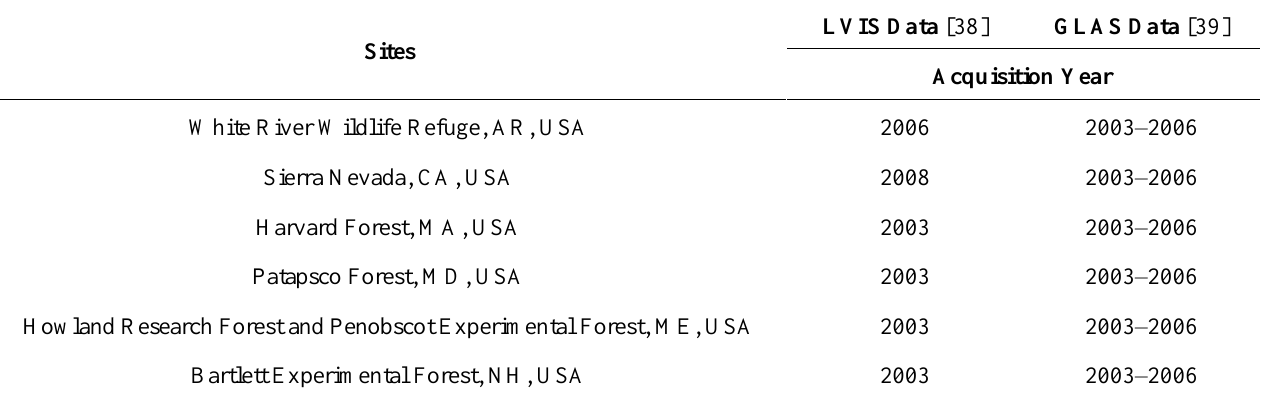
Table 2. Datasets for inter-comparisons between LVIS derived heights and Geoscience Laser Altimeter System (GLAS) height metrics (six different sites used in this